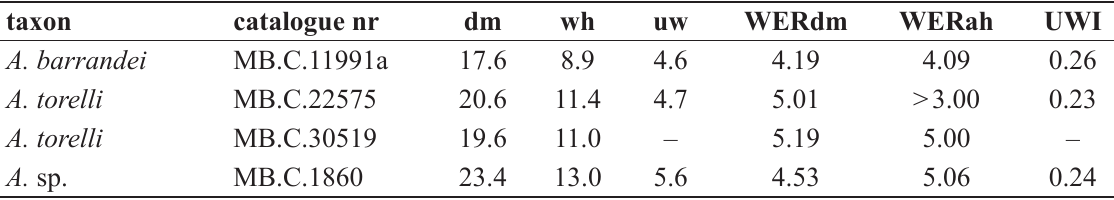
Table 4. Conch measurements (in mm), ratios and rates of coiled conch parts of Ancistroceras Boll, 1857.